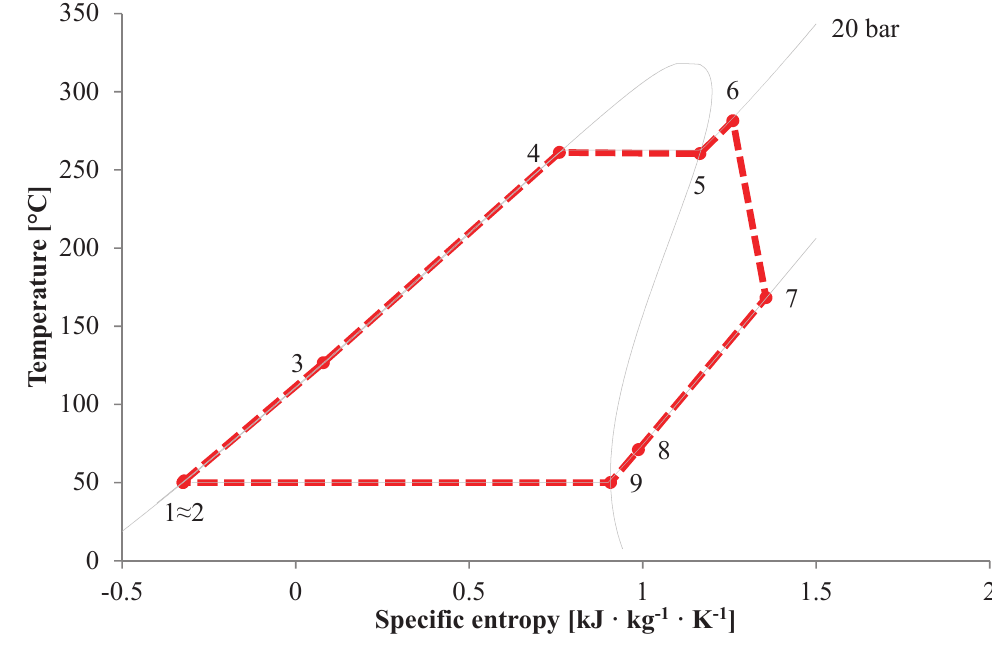
Figure 2. T - s diagram showing the thermodynamic cycle state points of the ORC turbogenerator at design-point. Toluene is the working fluid. Isobaric lines and saturation dome are also reported; pressure drops are